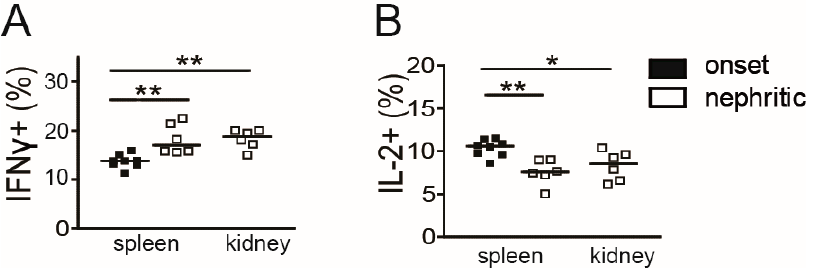
Figure 3. Low frequency of intrarenal IL-2 producing e ff ector / memory T cells in active lupus nephritis. Sorted CD4 + T cells from single spleens and kidneys of individual mice at the indicated disease stage were stimulated with PMA / ionomycin for 5 h and the frequencies of IFN- γ ( A ) and IL-2 ( B ) producing cells among CD3 + CD4 + CD44hi memory T cells were determined by flow cytometry (onset: n = 8 and nephritic: n = 6). Horizontal lines represent the median. Mann-Whitney U test was used for statistical analyses (* p < 0.05 and ** p < 0.01).